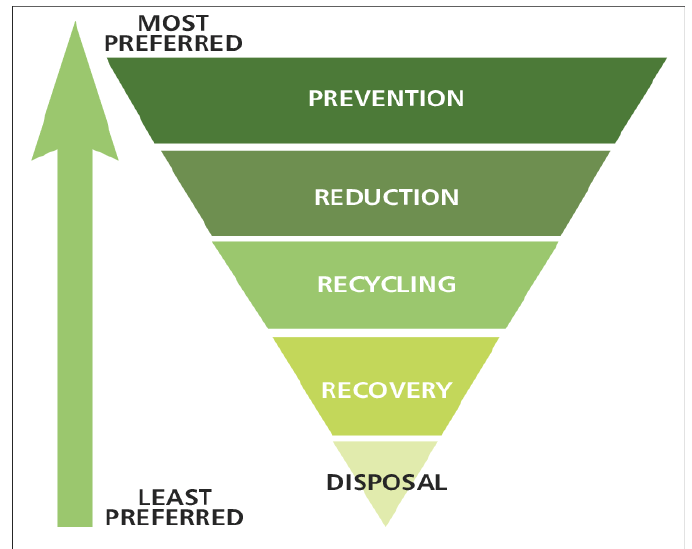
Figure 2. The waste management hierarchy (Adapted from UNEP,